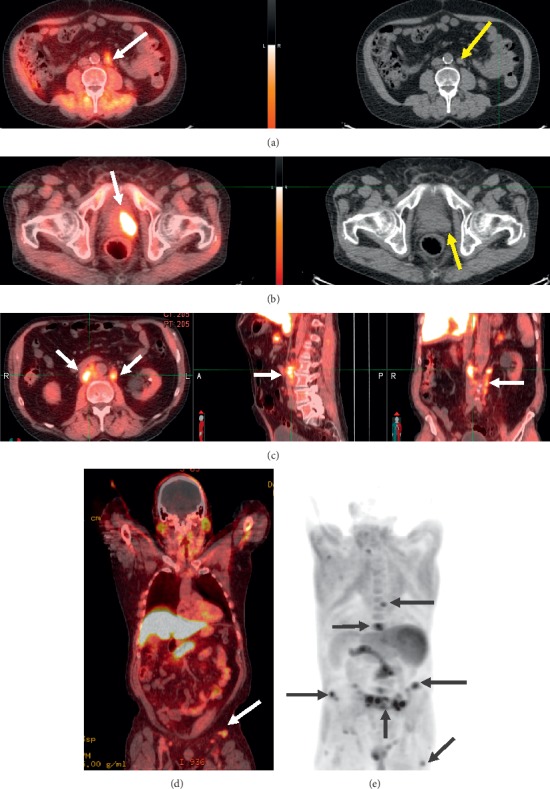
Elements recommended for determining likelihood of prostate cancer in given lesions (identified by arrows). (a) Comparison of fluciclovine uptake in nonosseous lesions to background; this is a para-aortic lymph node on fused axial image (left) and CT (right). (b) Lesion located at typical site of prostate cancer recurrence in the prostate gland in a patient given radiotherapy as initial definitive treatment (left image is axial fused and right image is corresponding CT). (c) Lesion located at typical site in lymph nodes (left image is axial fused, middle image is sagittal, and right image is coronal view). (d) Lesions located at atypical site for prostate cancer (lymph nodes). (e) Bone lesions as seen on an MIP image.